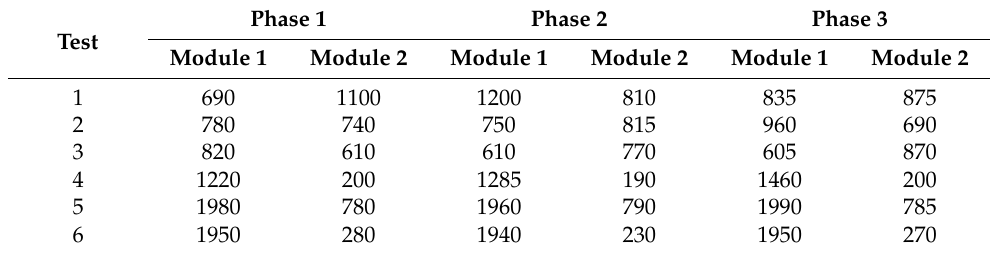
Table 4. Effective transistors’ switching frequency